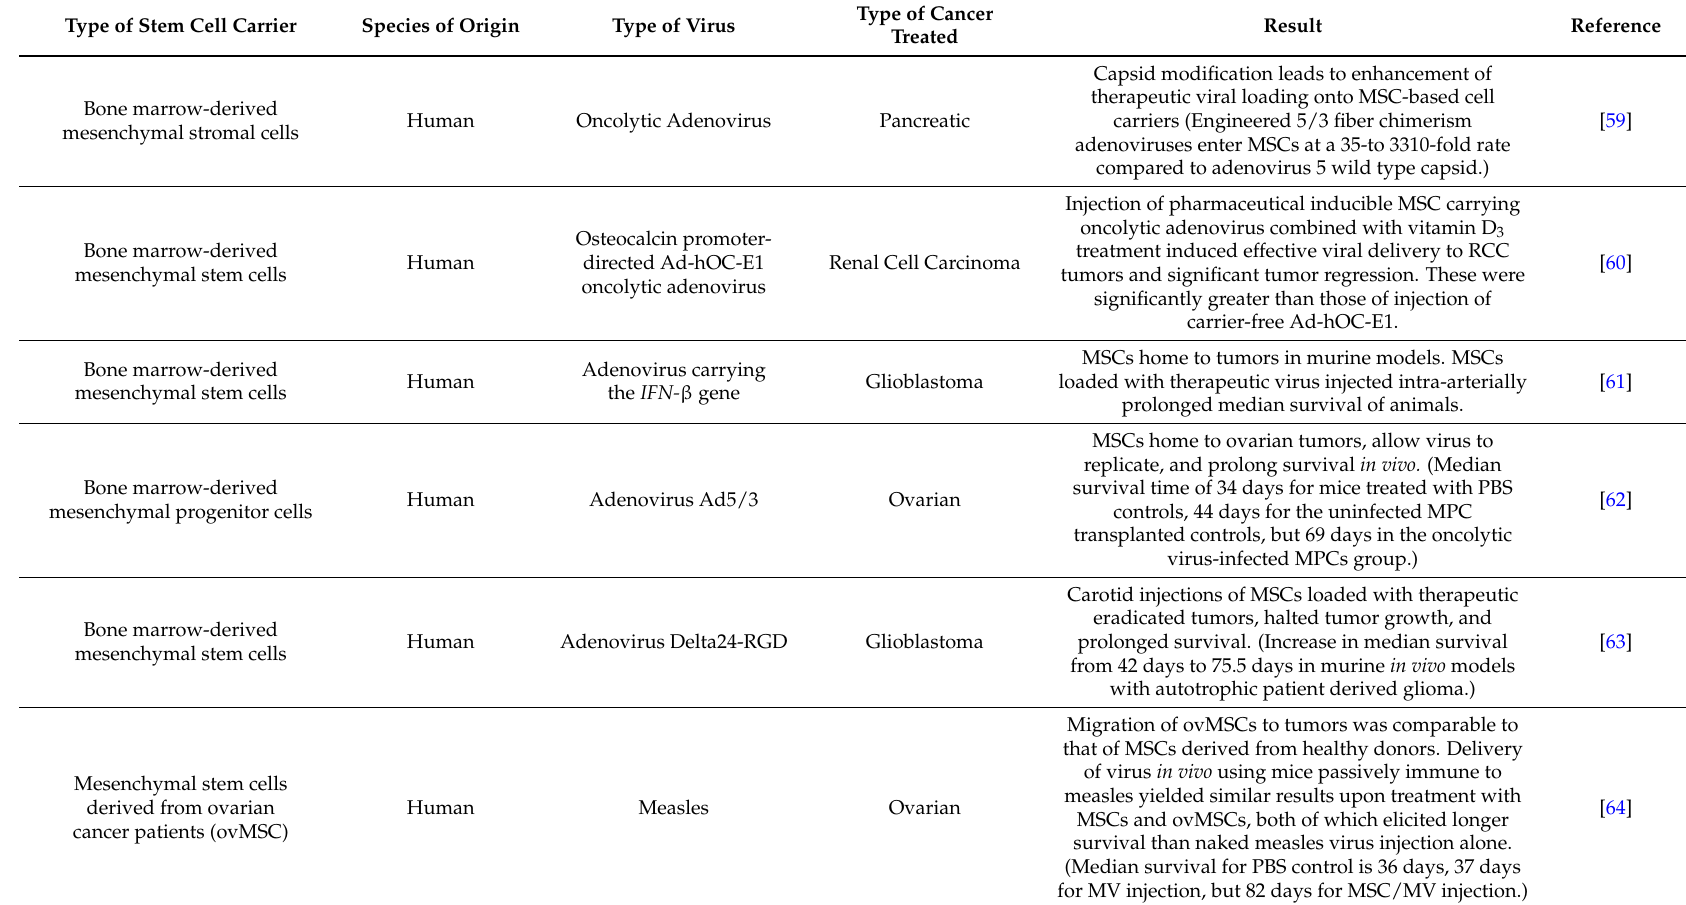
Table 2. Summary of preclinical trails using stem cells for oncolytic virotherapy treatments. Studies investigating mesenchymal stem cells are listed first, followed by studies examining neural stem cells. The type of virus loaded and cancer treated are catalogued. Results and citation of each preclinical trial are also